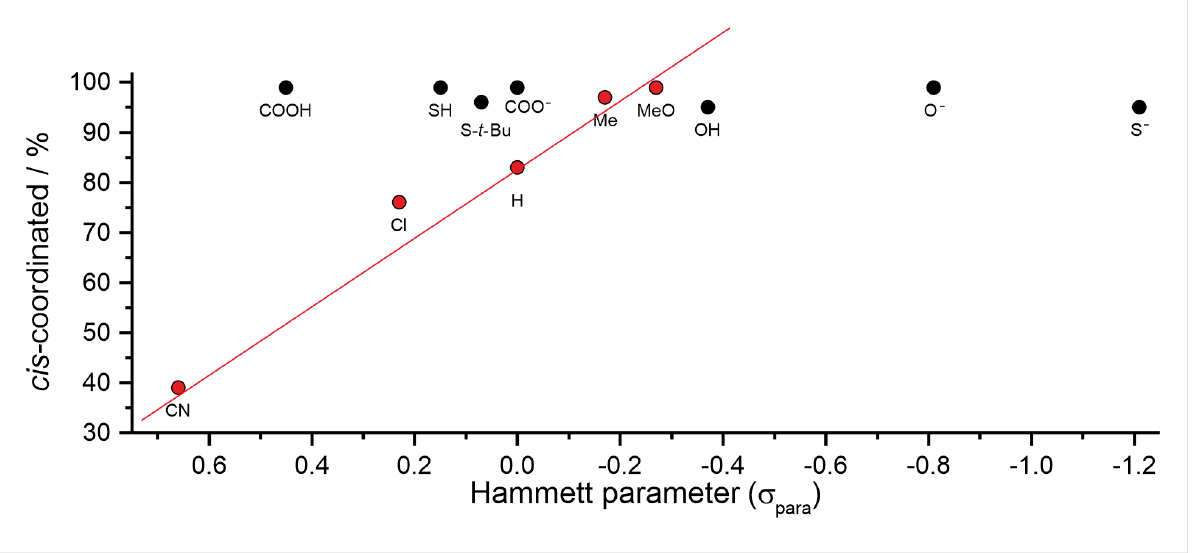
Figure 2: Hammett plot of the investigated pyridine substituents [36].